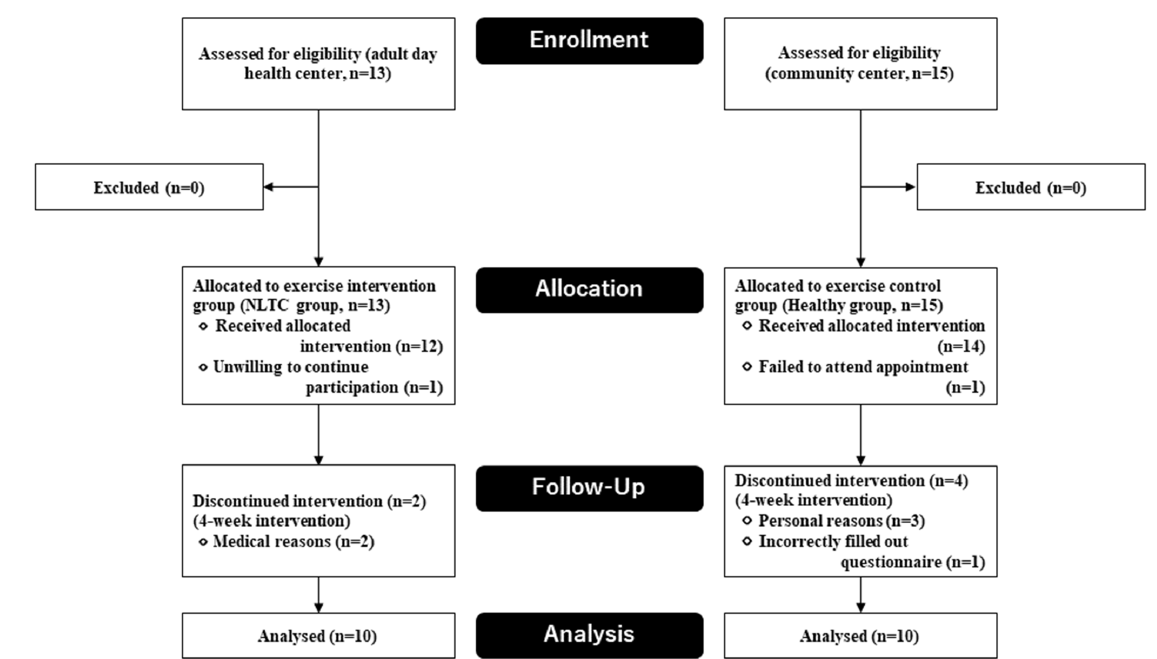
Figure 1. Flow diagram of the participants. Table 1. Baseline characteristics of the